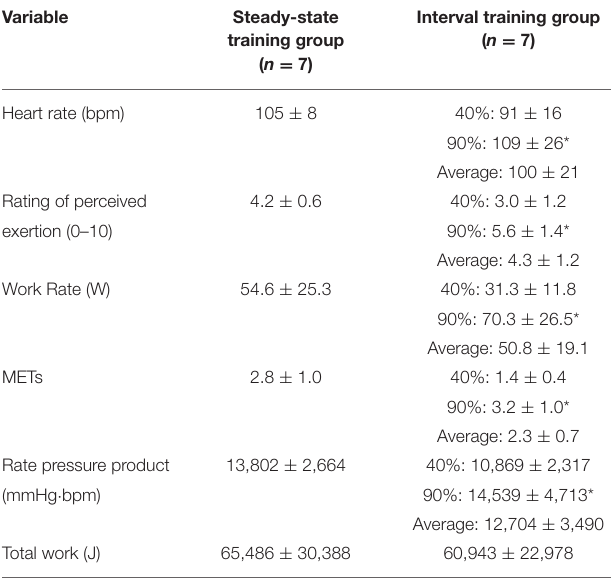
TABLE 3 | Exercise responses during steady state and interval training sessions (values are means ± SD).